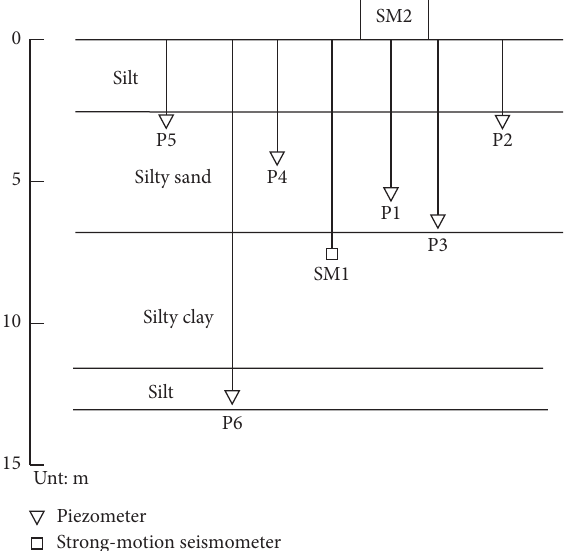
Figure 2: The cross section and instrumentation at the Wildlife Site Array (after Holzer [23]).